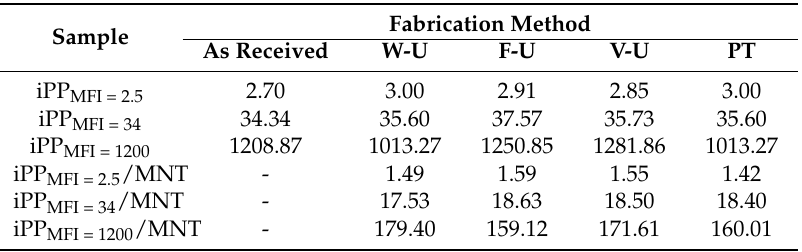
Melt Flow Index (g/10 min) for isotactic polypropylenes (iPP) homopolymers,